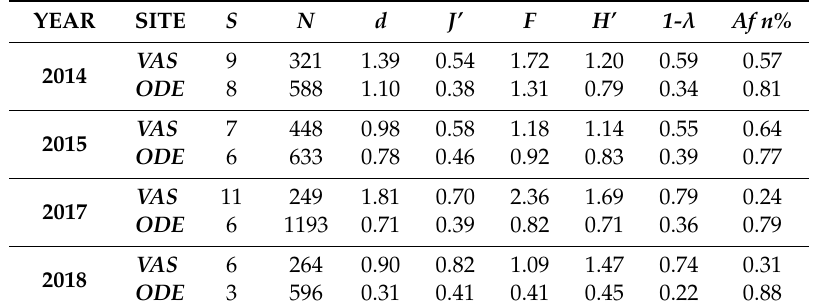
Table 1. Diversity indices for the Vasc ã o ( VAS ) and Odelouca ( ODE ) fish assemblages. S :